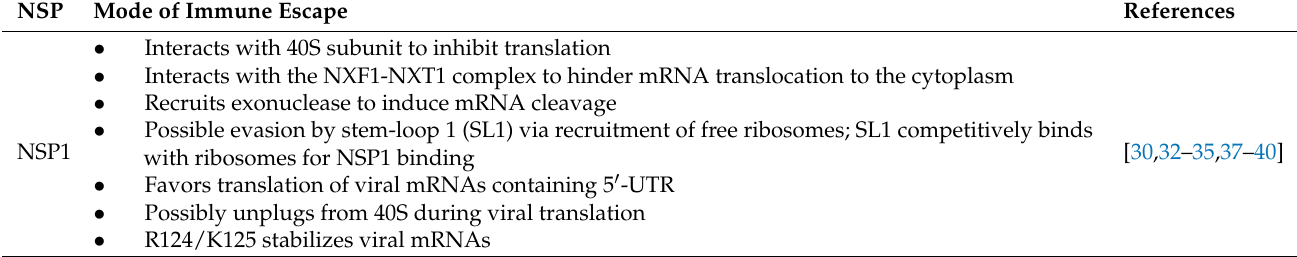
Table 2. Summary of functions of SARS-CoV-2 non-structural proteins (NSPs) and their modes of immune